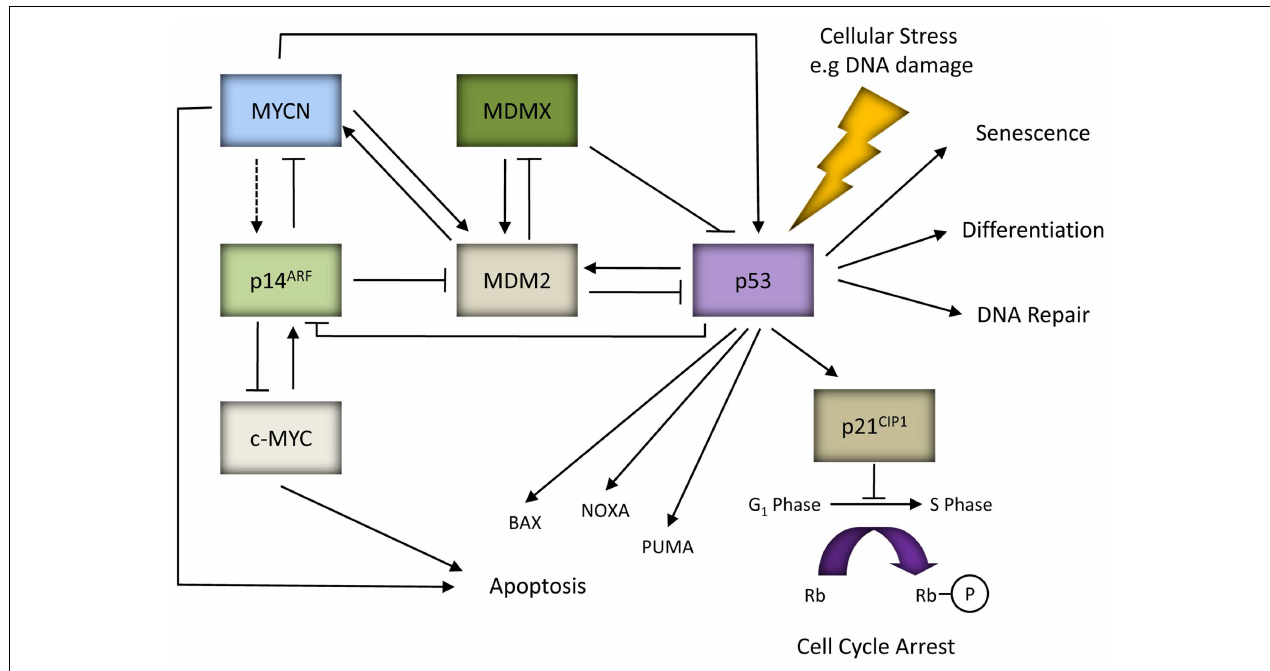
response to aberrant oncogenic factors such as c-MYC, and possibly MYCN (as indicated by the dashed line). p14 ARF can also exhibit p53-independent tumor suppressor activity by directly binding and inhibiting the activity of c-MYC and MYCN. Both p53 and MDM2 are direct target genes of MYCN. MDM2 can regulate MYCN mRNA stability and translation, thereby forming a positive feedback